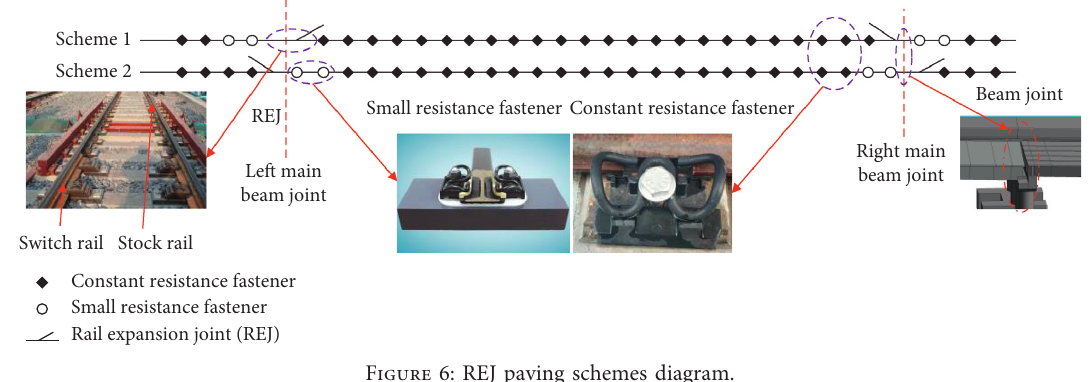
Figure 6: REJ paving schemes diagram.